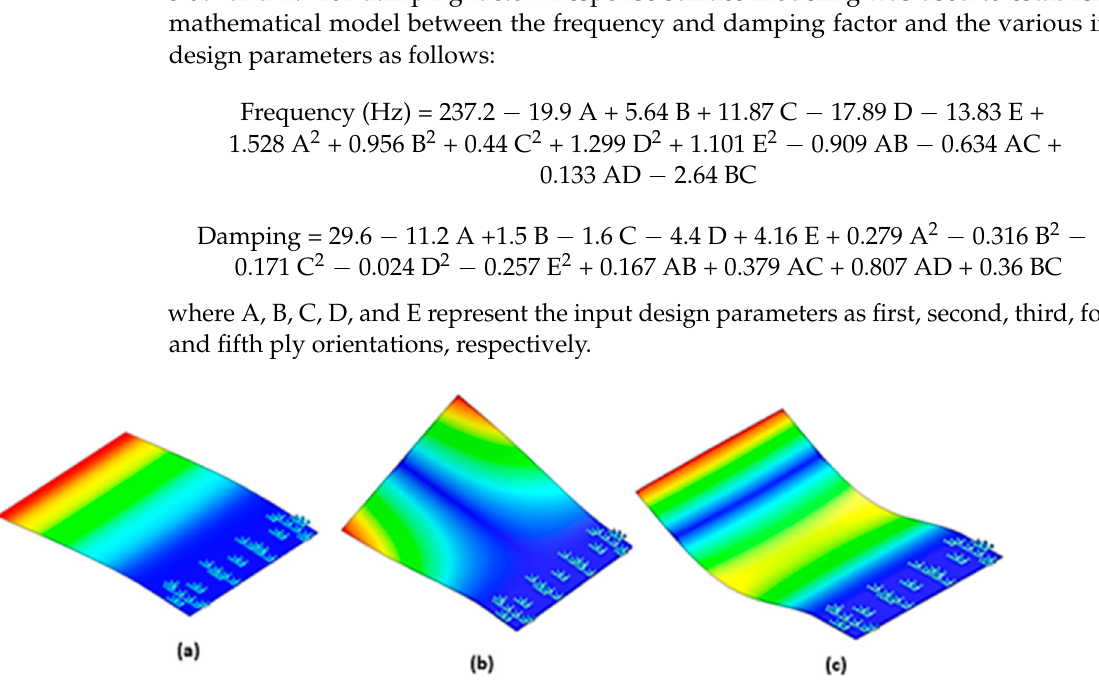
Figure 6. Mode shapes of the optimum frequency configuration: ( a ) first mode, ( b ) second mode, and ( c ) third mode.